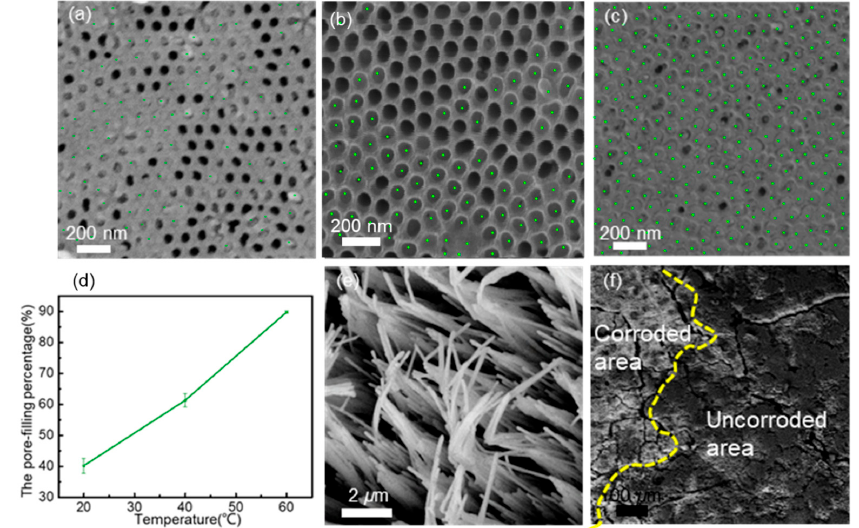
Figure 5. Top-view of CNPs filled AAO film interposer with different temperatures in 8 h: ( a ) 20 °C; ( b ) 40 °C; ( c ) 60 °C; and ( d ) the relationship of the pore-filling percentage versus electrodeposition temperature; ( e ) top-view of the corroded area at 60 °C; and ( f ) the whole area at 60 °C.